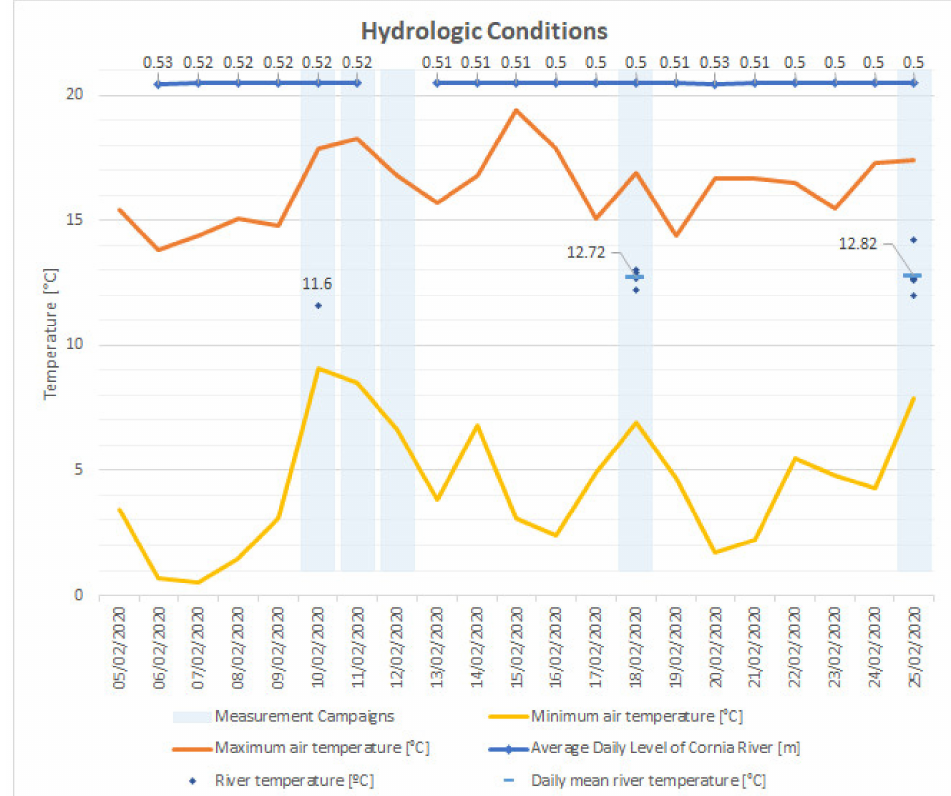
Figure 5. Hydrologic conditions at the MAR site during the